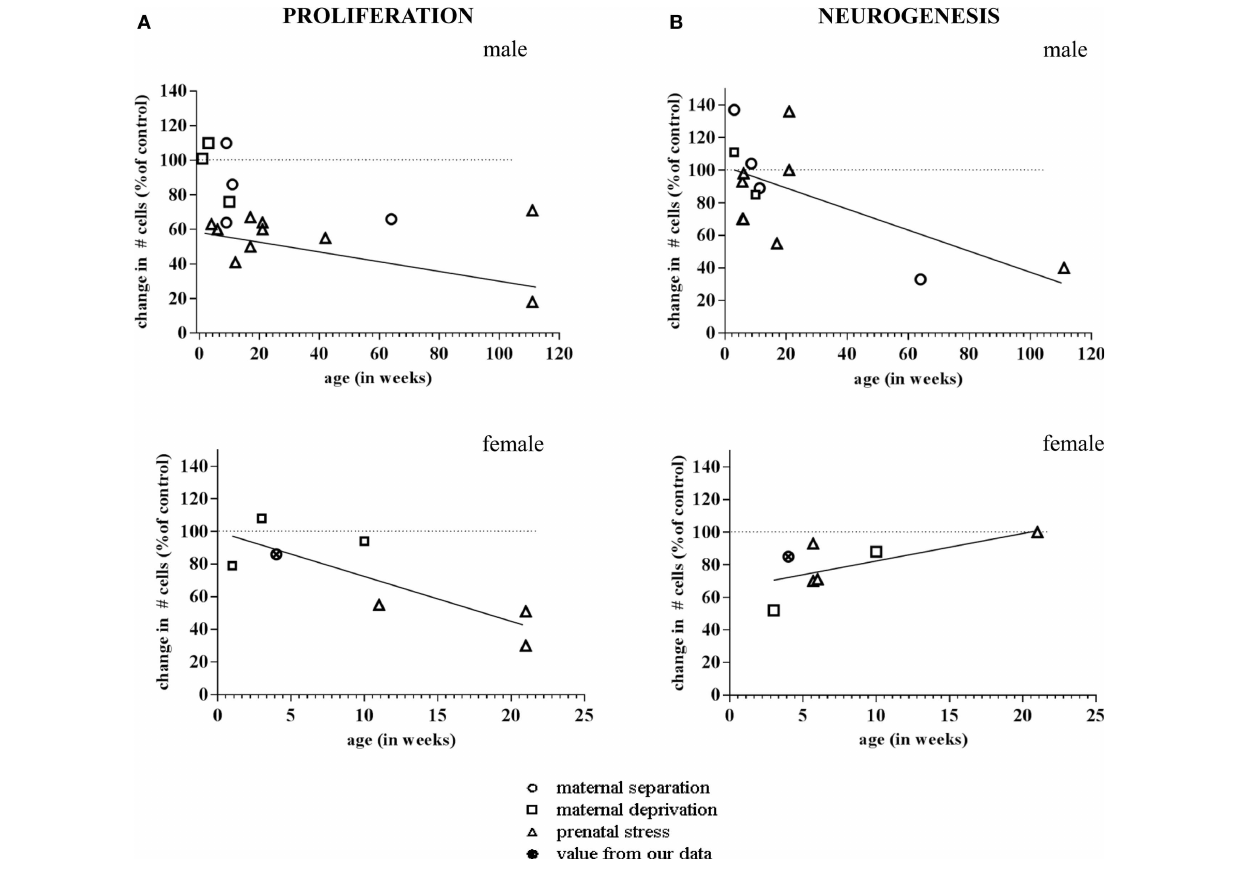
FIGURE 2 | Meta-analysis of age- and sex-dependent effects of early life adversity on neurogenesis .The graphs show the percentage change in number of Ki-67 and Doublecortin (DCX)-positive cells after perinatal stress ( y -axis; 100% is control), as a function of the age at which the change in neurogenesis was determined ( x -axis, in weeks). (A) Both in males (top) and females (bottom), the change in number of Ki-67 positive cells due to prenatal (triangle), maternal separation (diamond) or maternal deprivation (square) was negatively correlated to the age at which the effect was determined. (B) In male rodents (top), the number of DCX-positive cells was found to be enhanced by perinatal stress when examined at a very young age.When studied at time-points > 2months of age, generally a decrease in the number